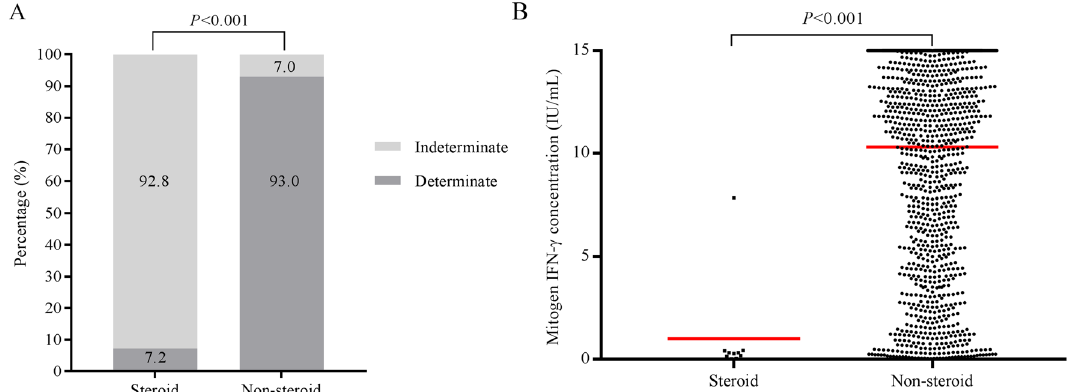
Figure 3. ( A ) Proportion of indeterminate QFT-GIT results in the low-dose steroid group and non-steroid group. ( B ) IFN-γ response to mitogen control PHA (censored at 15 IU/mL) in children with and without low-dose steroid therapy. The red lines indicate the median values. P values were calculated using the Mann– Whitney U test. QFT-GIT QuantiFERON-TB Gold In-Tube, IFN-γ